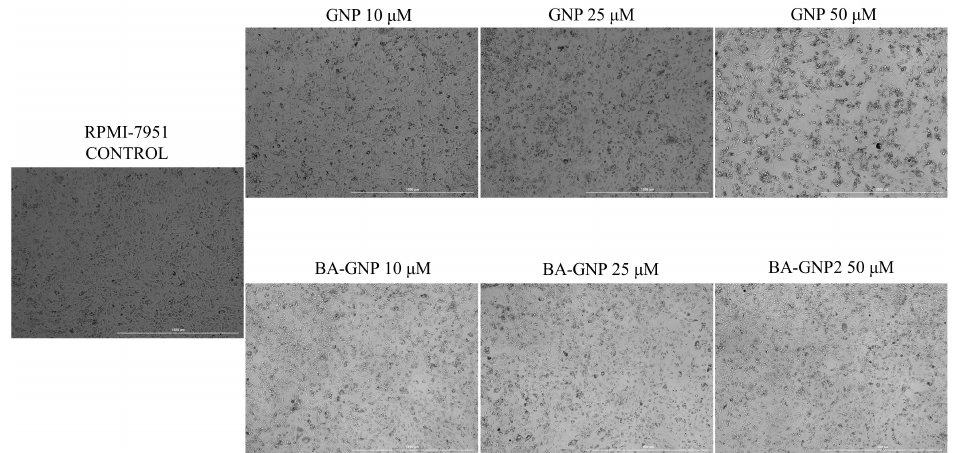
Figure 9. Representative images of the morphological aspect of RPMI-7951 cells after treatment for 24 h with GNP (diluted to match the same gold content as for BA-loaded NPs at 10, 25 and 50 μΜ ) and BA-GNP (10, 25 and 50 μΜ ). The scale bar was 100 μ m.